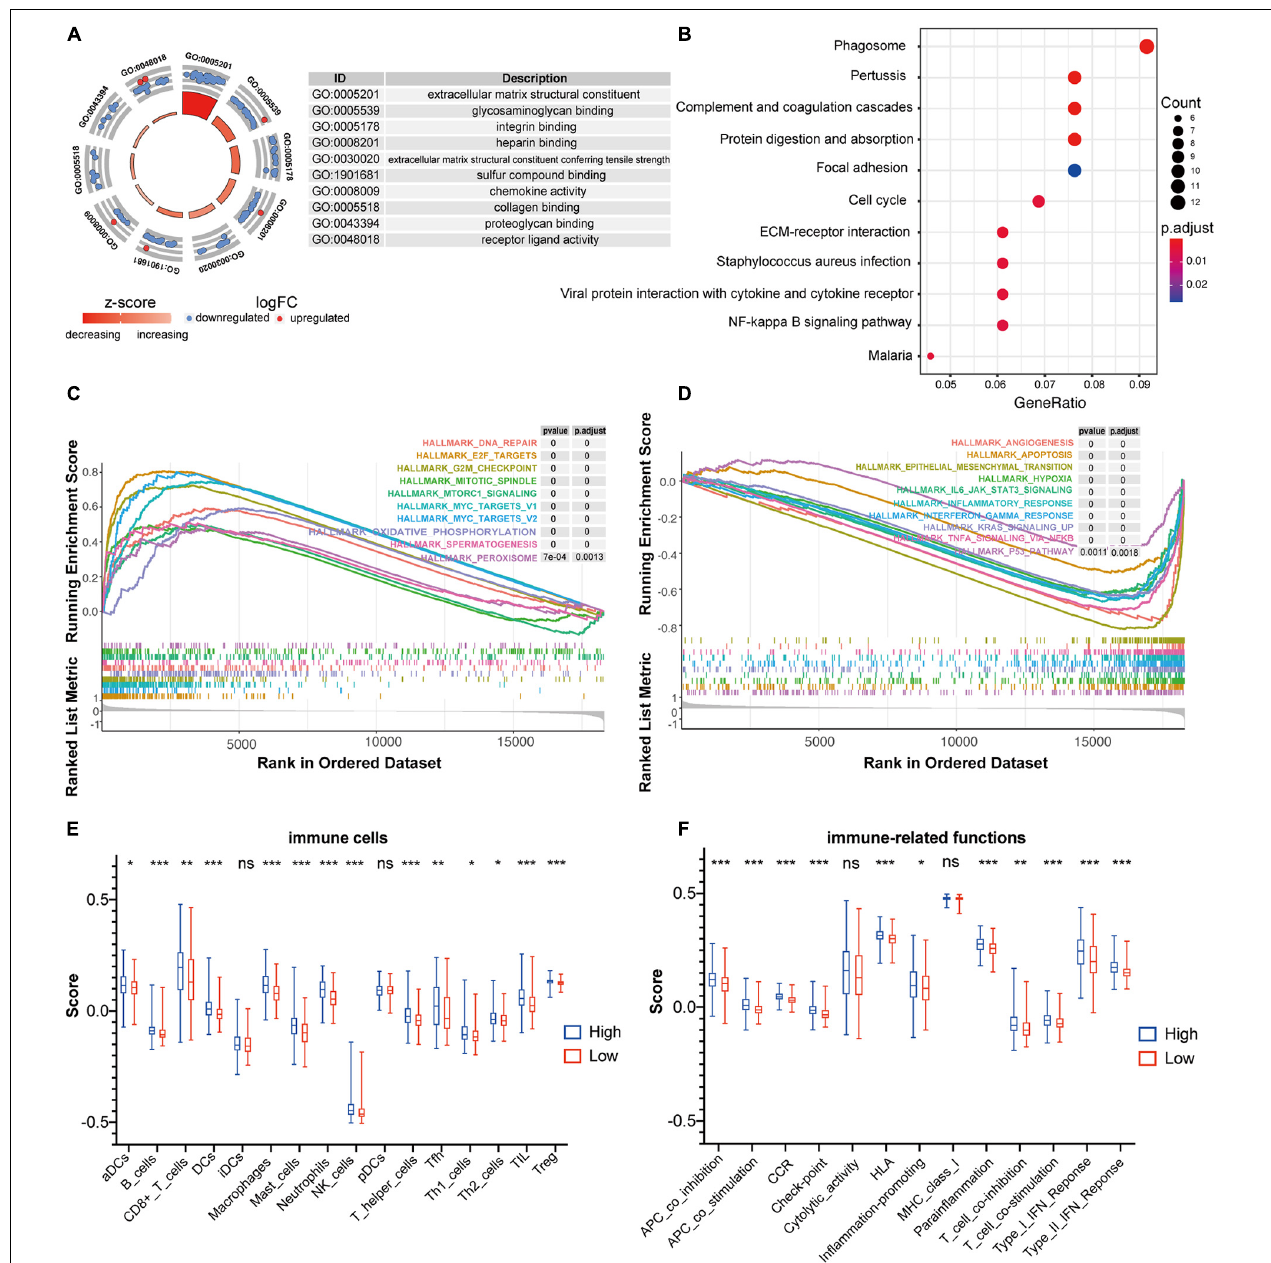
FIGURE 6 | Functional annotation of the FRG prognostic signature. (A) Circle plot shows the top ten enriched GO terms for the DEGs identified between high- and low-risk groups in the training dataset of GSE39582. (B) Bubble diagram shows the enriched KEGG pathways for the DEGs identified between high- and low-risk groups in the training dataset of GSE39582. (C,D) GSEA analysis was used to explore cancer hallmarks that enriched in the high-risk subgroup (C) and low-risk subgroup (D) of the GSE39582 dataset. (E) Comparison of the ssGSEA scores of 16 immune cells between high- and low-risk groups in the GSE39582 dataset. Statistical significance was calculated using the Student’s t -test ( p < 0.05). * p < 0.05; ** p < 0.01; *** p < 0.001. (F) Comparison of the ssGSEA scores of 13 immune-related functions between high- and low-risk groups in the GSE39582 dataset. Statistical significance was calculated using the Student’s t -test ( p < 0.05). * p < 0.05; ** p < 0.01; *** p <